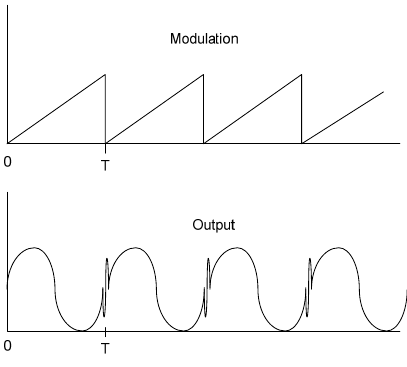
(cid:16) d φ (cid:17) T = 2 π is satisfied. dt